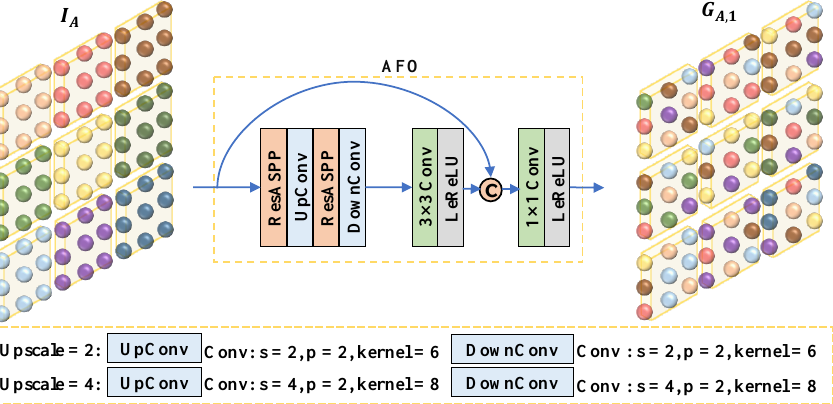
Figure 4. Detailed illustration of angular interaction operator (AFO). For better comprehension, each SAI of size U = V = 3, H = W = 3 is used as a toy example. To better visualize the information of each SAI, pixels from different SAIs are painted with different colors, while pixels from the same SAI are painted in the same color for simplicity. Due to different upsampling factors, we set different convolution parameters to keep the size of the feature map the same as that of the final feature map. Specifically, s and p denote stride and padding, respectively. The proposed AFO can integrate features from other different SAIs for each